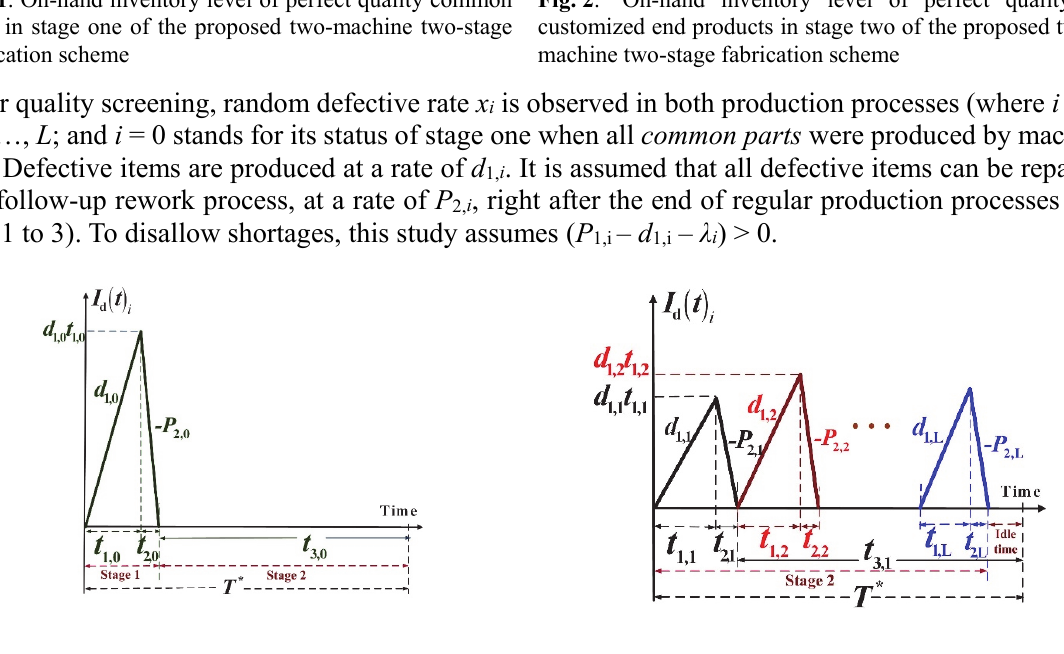
Fig. 3 . On-hand inventory levels of defective common intermediate parts in stage one (left) and defective customized end products in stage two